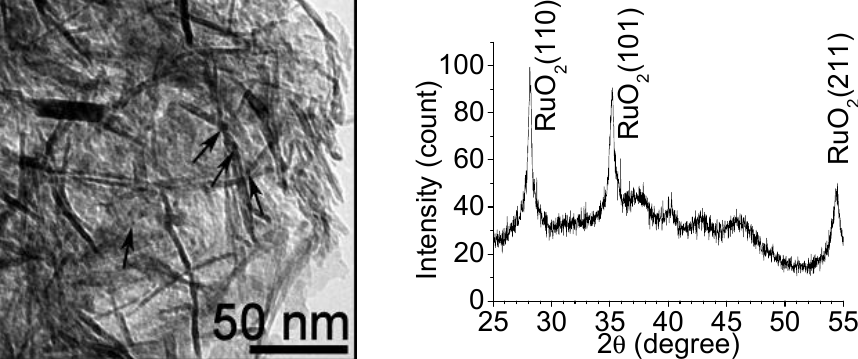
O catalyst. XRD shows the existence of RuO 2 3